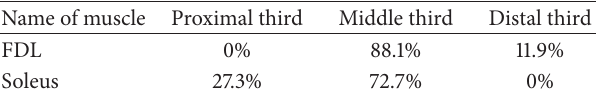
Table 3: Mean percentage distribution of length of attachment for muscles located in different segments of the posteromedial border of